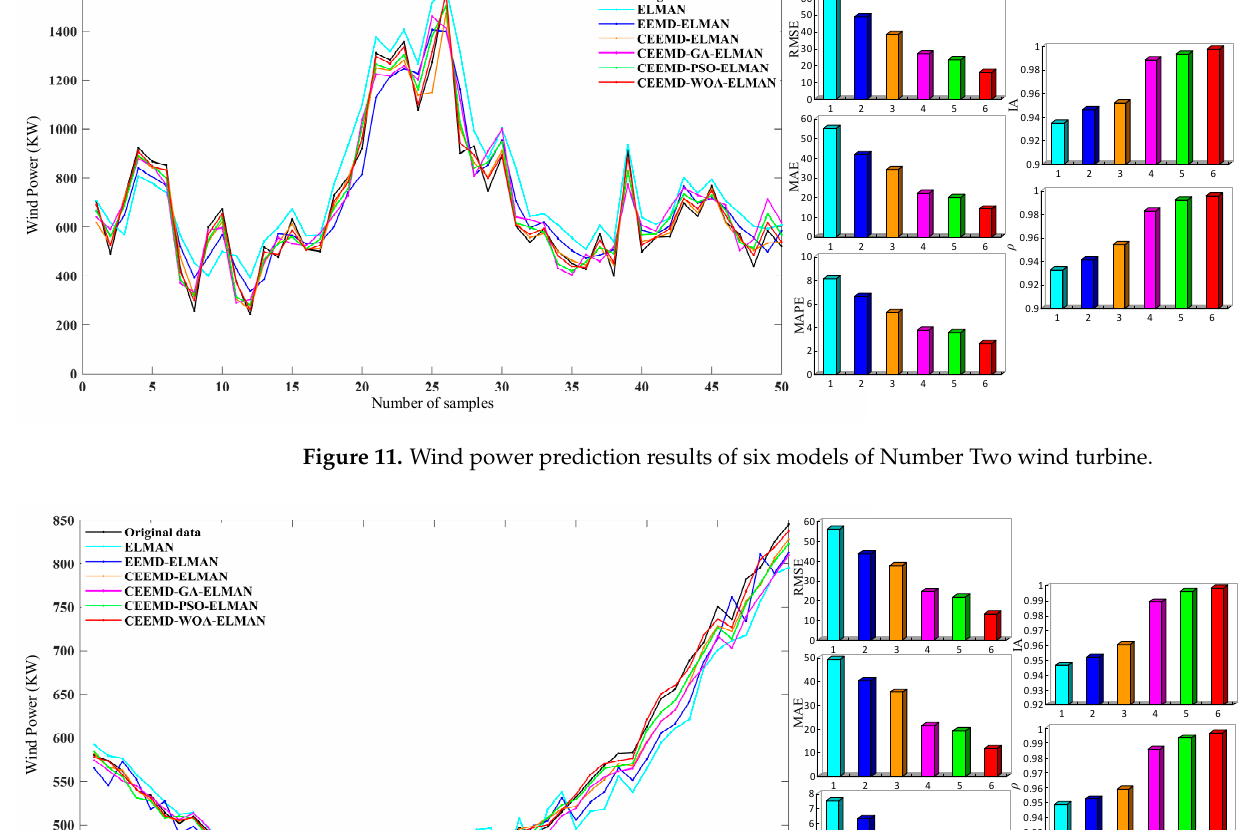
Figure 10. Reconstruction error of EEMD and CEEMD.